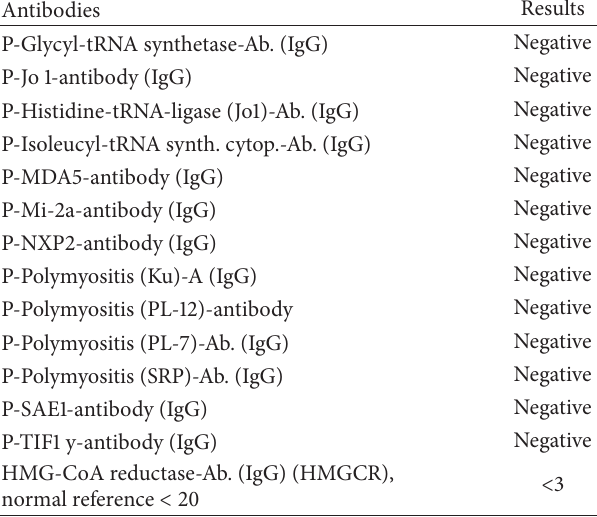
Table 2: Screening for autoantibodies known to be associated to polymyositis, dermatomyositis, and isolated statin (HMG-CoA reductase inhibitor) causing myalgia.